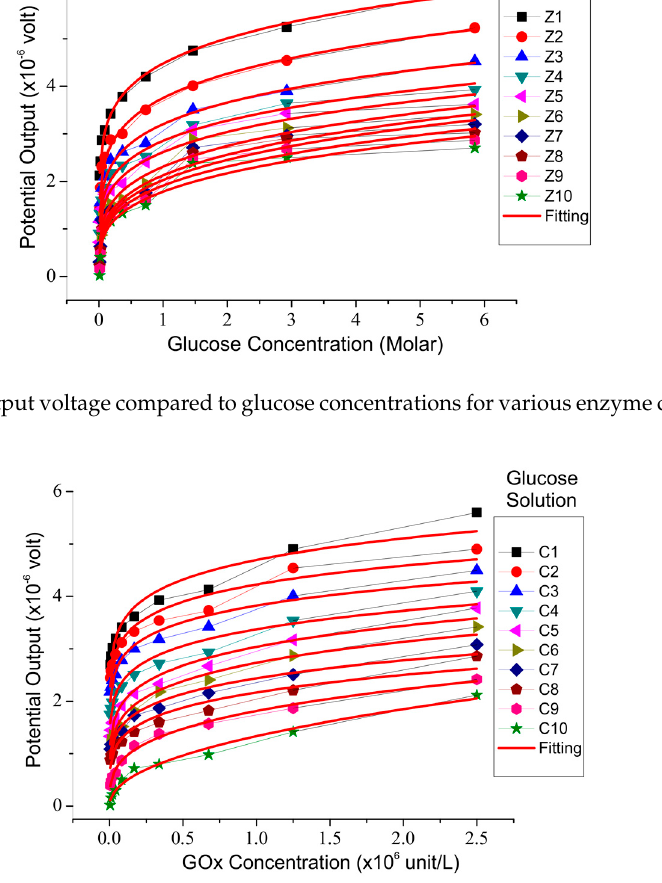
Figure 6. Sensor output voltage compared to enzyme concentrations for various glucose concentrations.